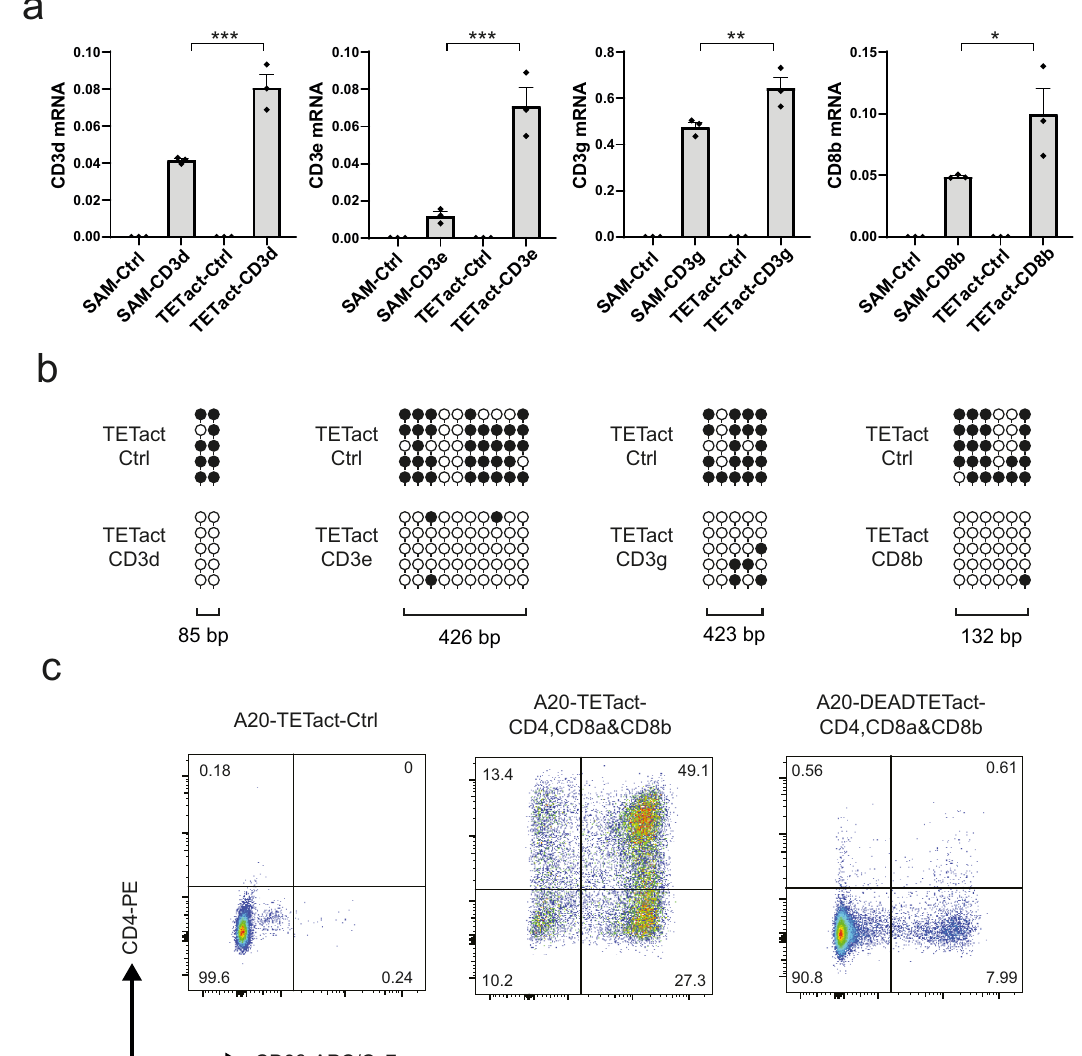
Fig.3|TETactactivationofothergenesinA20.a Expressionof Cd3d , Cd3e , Cd3g and Cd8b in A20 SAM or TETact cells transduced with the promoter-targeting sgRNA. Expression level is relative to Actb as 2 − Δ Ct . P =0.0002 ( Cd3d ), 0.0002 ( Cd3e ), 0.0091 ( Cd3g ), 0.0391 ( Cd8b ) from one-way ANOVA with Tukey ’ s post hoc test. Data are shown as mean±s.e.m. from three independent transductions. * P <0.05, ** P <0.01, *** P <0.001. b Bisulphite sequencing of Cd3d, Cd3e, Cd3g and Cd8b promoters for A20-TETact cells transduced with either control or the corre- sponding sgRNAs. Open lollipops indicate non-methylated CpG dinucleotides